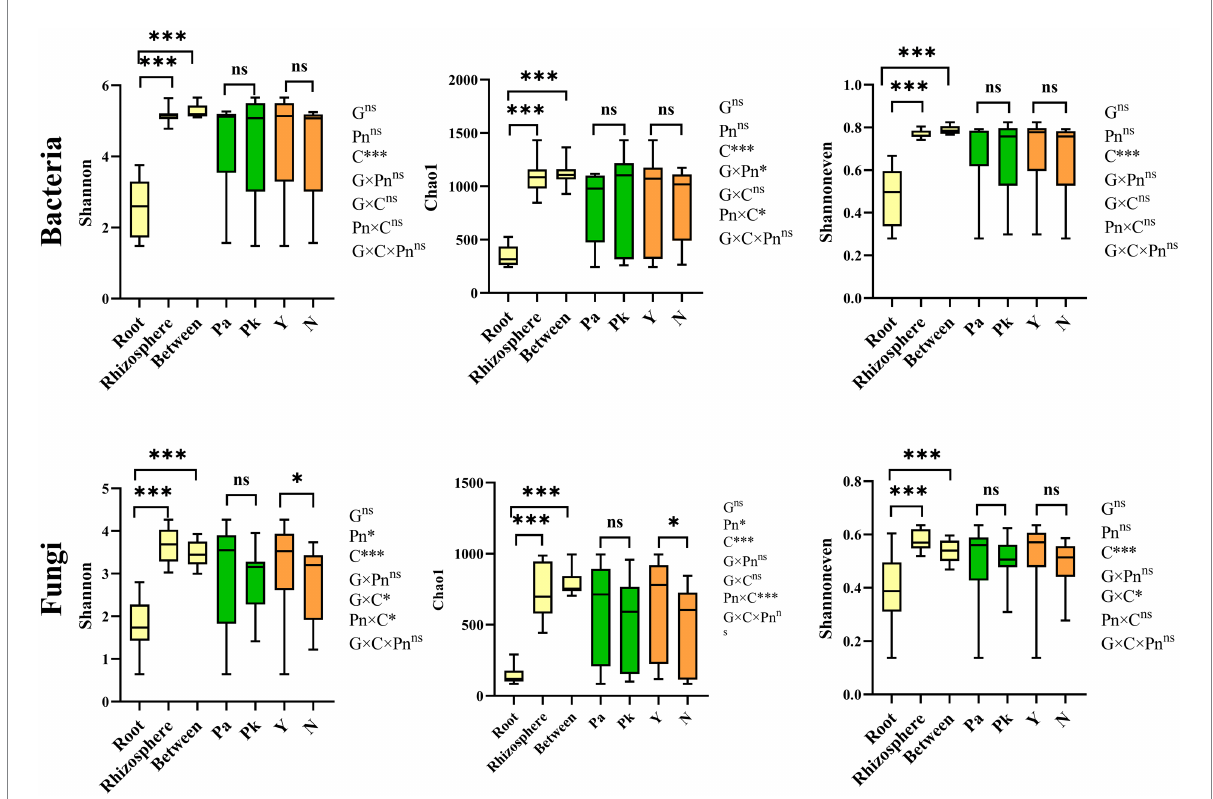
FIGURE 3 Boxplots of indices of bacterial and fungal alpha diversity of microbes in samples from different compartments (between (bulk) and rhizosphere soils, and root of pine trees), genotype and planting P.n. or not. Different letters showed significant difference ( p < 0.05). The Significance of effects of genotype (G), compartment (C) and planting P.n. or not (Pn) and their interactions on microbial diversity was evaluated by multi-way ANOVA. * , p < 0.0 5, and *** , p < 0.001, ns, no